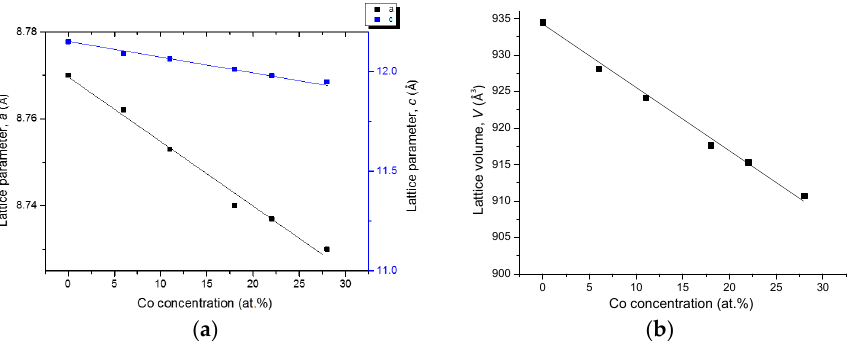
Figure 17. Cell parameters a and c ( a ) and lattice volume V ( b ) with Co concentration for the Ce 2 (Fe, Co) 14 B from KAs 1–5.